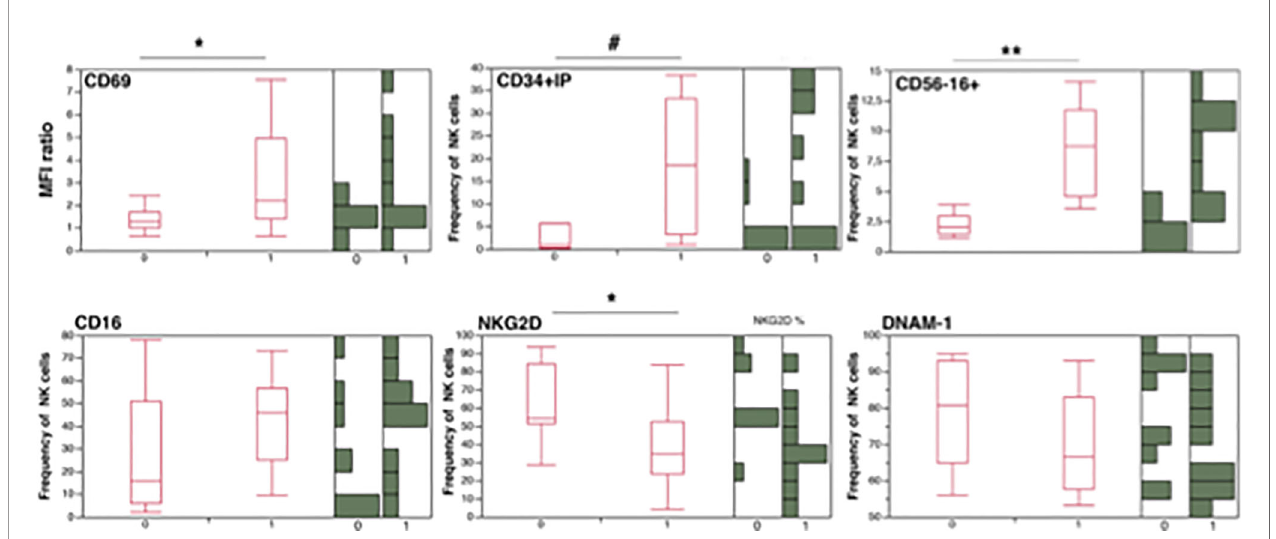
FIGURE 4 | Natural killer and in fl ammatory precursor cell frequencies in PHIV patients after strati fi cation for presence (1 = uDNA+) or absence (0 =uDNA-) of detectable uDNA. Lateral histograms (Green) show individual measurement frequencies *p<0.05; **p<0.01; #p<0.001; CD34+IP= CD34 + in fl ammatory precursors (CD34 + DNAM-1 bright CXCR4 + ).